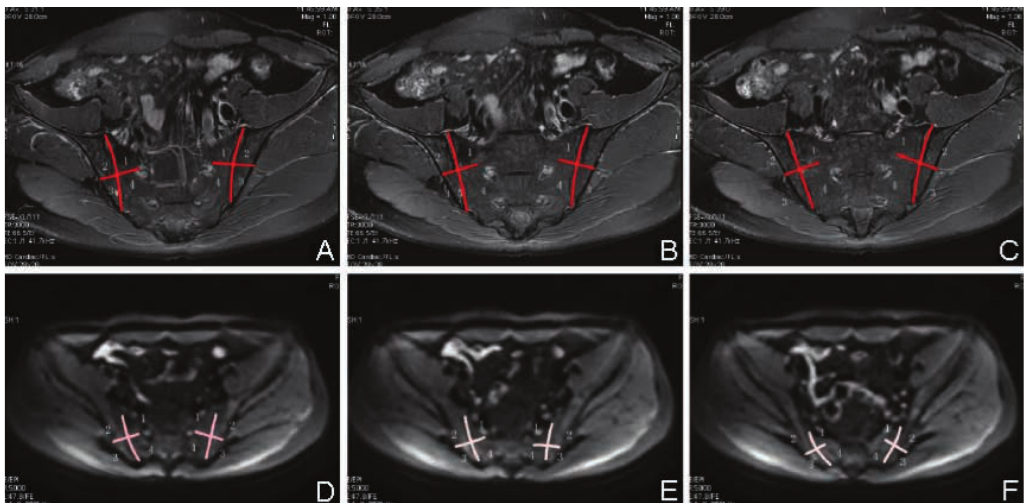
Figure 3: Bone marrow edema scoring on T2WI STIR sequence and DWI sequence in one patient. Bilateral sacroiliac joint was divided into four quadrants (1 supra-sacral, 2 supra-iliac, 3 infra-iliac, 4 infra-sacral), and scoring was performed following the principles above. A, B and C were STIR images, cumulative scoring was 2 points; D, E and F were DWI images, and the cumulative scoring was 15 points. This method could reflect some bone marrow edema which did exist but not shown in STIR sequence.